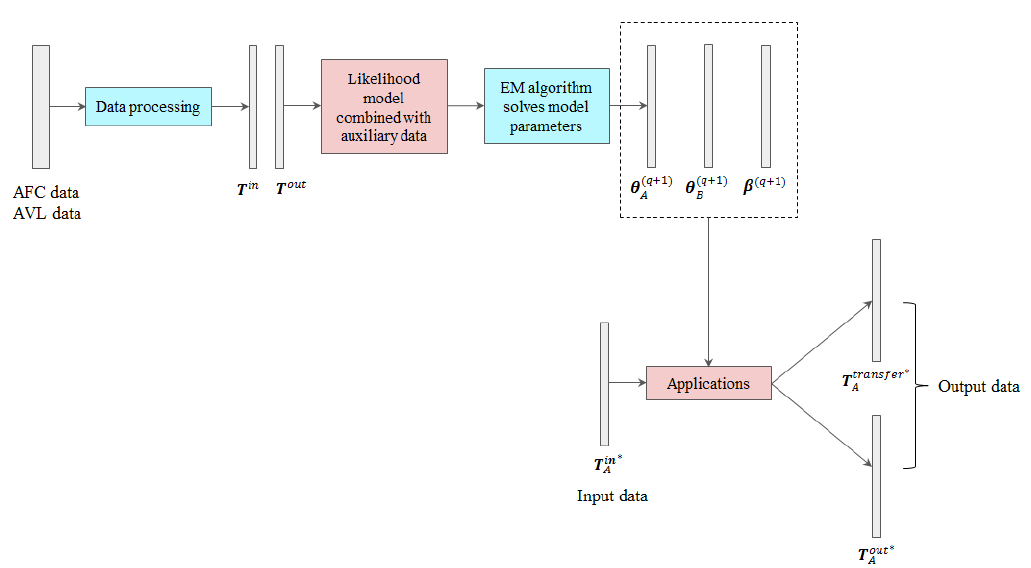
Figure 2. The diagram of the proposed